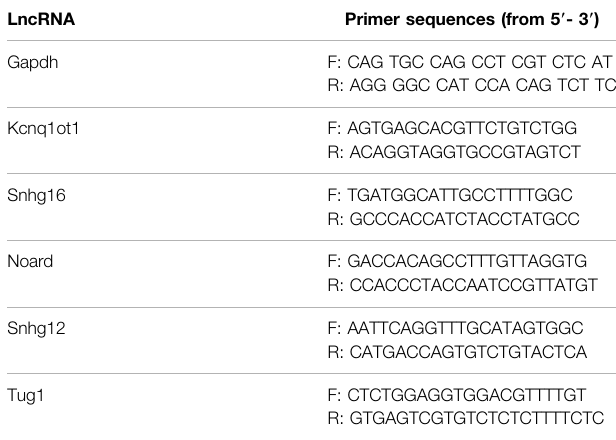
TABLE 1 | Primer sequences of lncRNA validated by